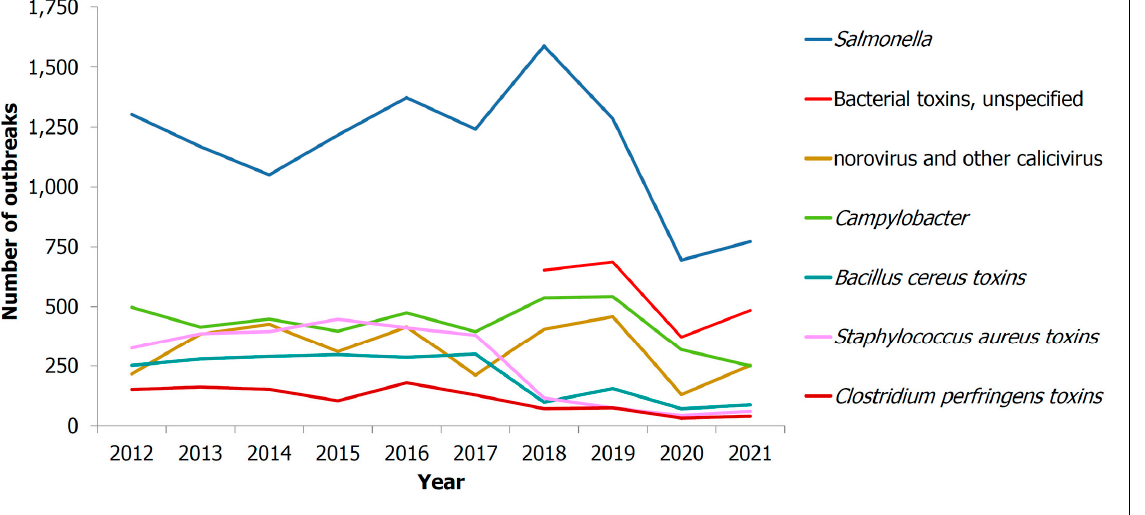
Figure 1. Number of foodborne diseases due to foodborne outbreaks in 2010–2021 Reprinted with permission from ref. [5].